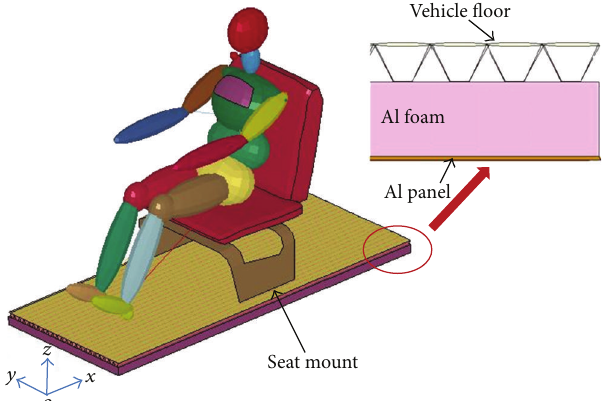
Figure 8: An innovative sandwich armor structure for blast- resistant.